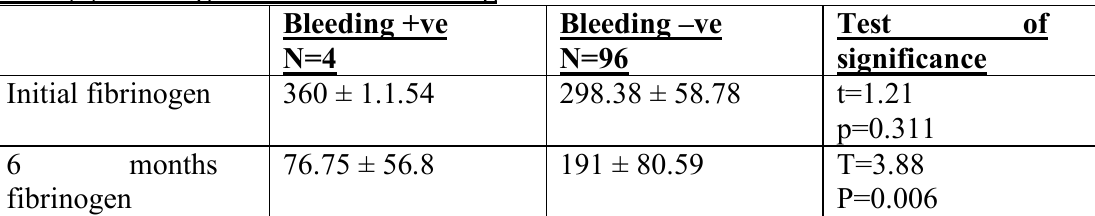
Table(4) fibrinogen relation to